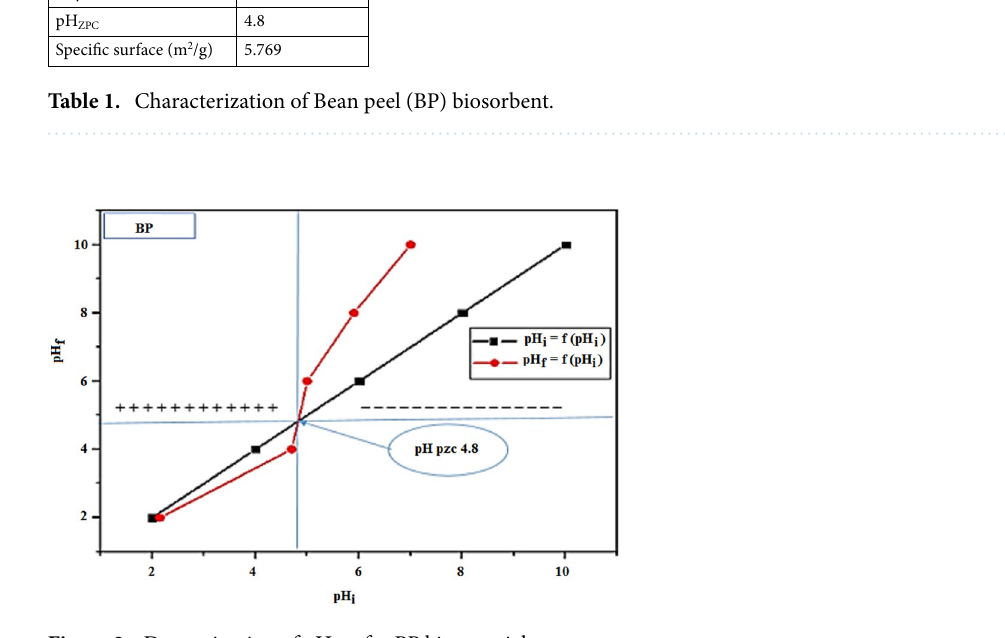
Figure 2. Determination of pH PZC for BP